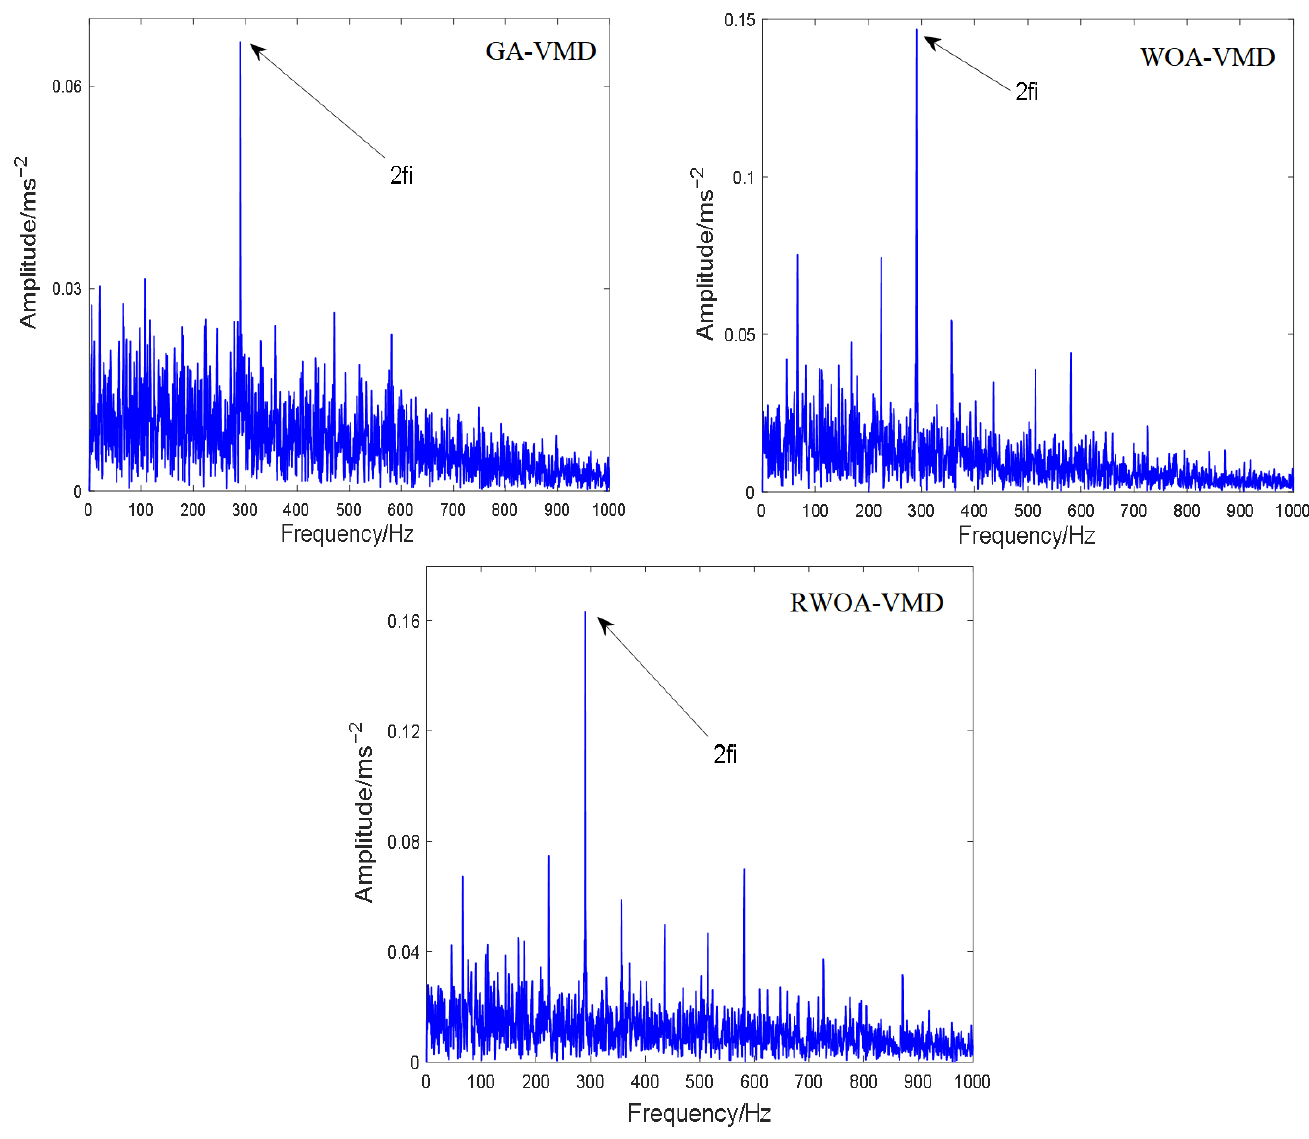
Figure 6. Comparison of processing effect directly using: GA-VMD, WOA-VMD and RWOA-VMD in the condition of exciter bearing with inner ring fault.